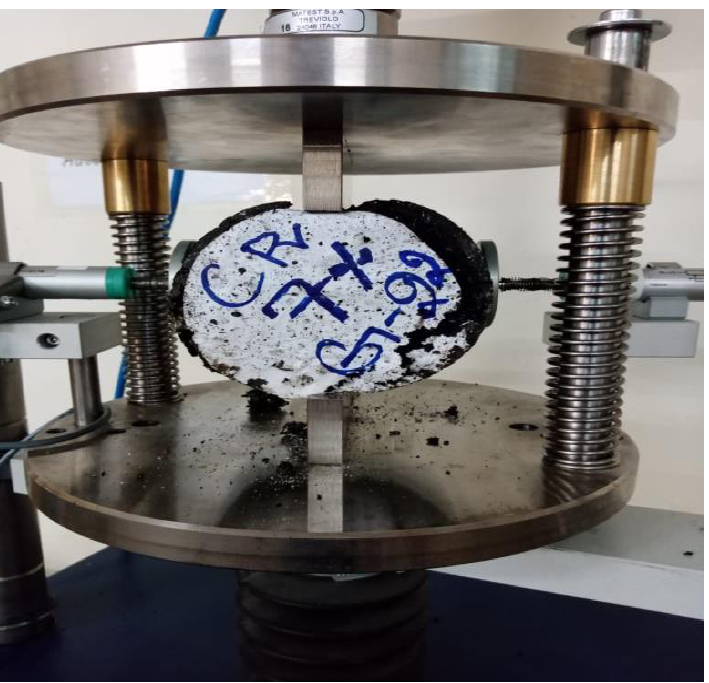
Figure 6. Testing of the asphalt concrete specimens for Indirect Tensile Strength (ITS).